Question: In one sentence, what is this figure communicating?
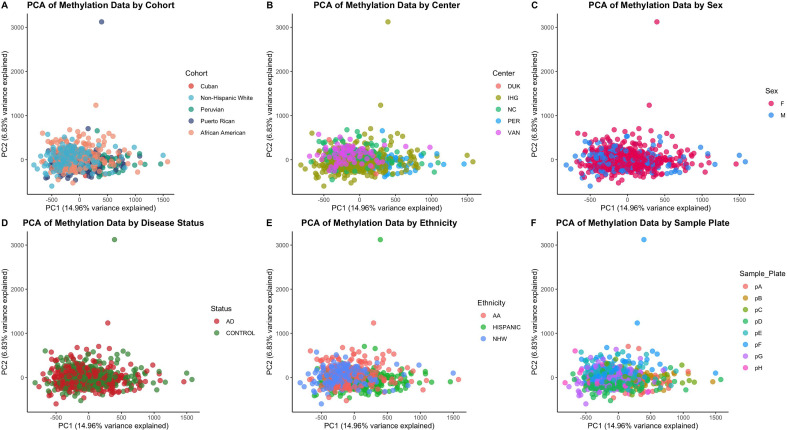
Answer: Principal component analysis (PCA) of MAGENTA methylation data. We performed a PCA of the normalized methylation data for all 621 MAGENTA individuals and calculated the variance explained by the first two PCs. PC1 explains 14.96% of the variance in the data, and PC2 explains 8.63% of the variance. Importantly, coloring the samples by cohort, sample center, sex, disease status, ethnicity, and sample plate did not show any outright stratification across the two PCs.